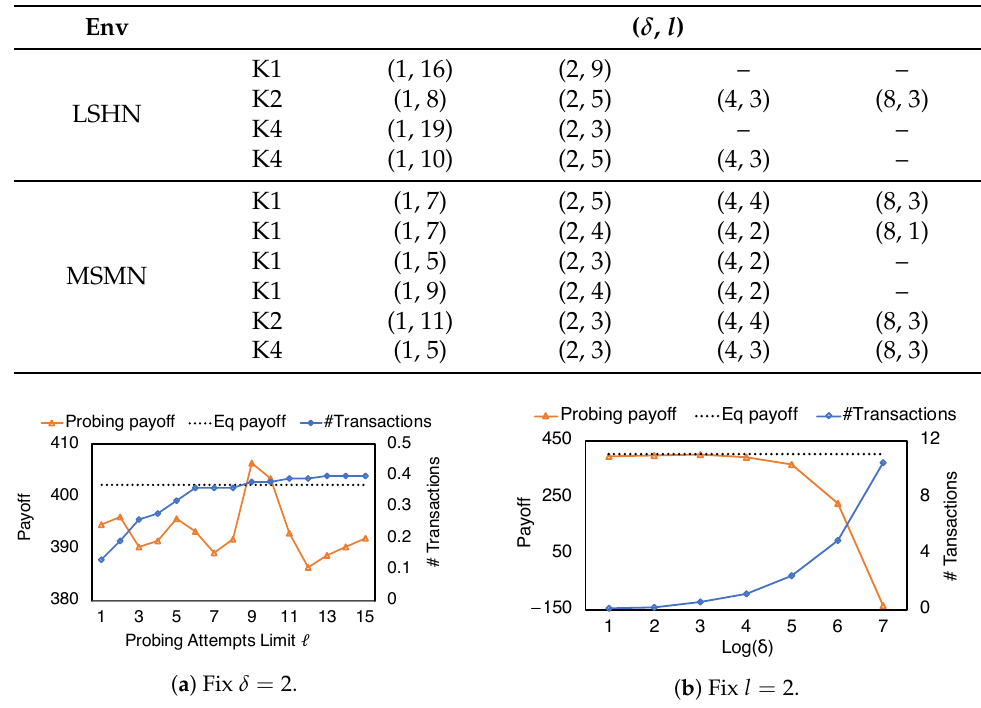
Figure 13. Exploitation payoff and transaction risk as we vary price increment δ and probing limit l